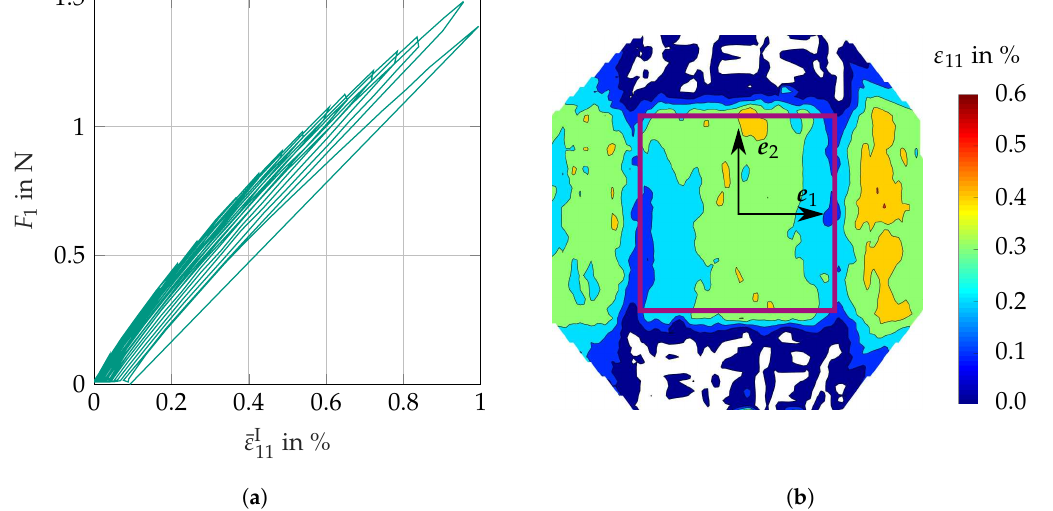
Figure 8. Bonded reinforcements on the arms with loading scenario P Γ = 0 . ( a ) Force F 1 in e 1 -direction over averaged normal strain in the area of interest ¯ ε I = 0.3%. at ¯ ε I 11